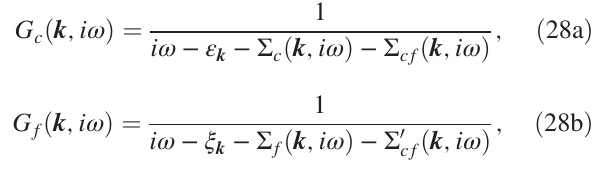
and (b) f fermions Σ 0 cf cf k ; ω Þð G k ; ω ÞÞ ; see Eqs. (28a) c ð f ð contractions and cf